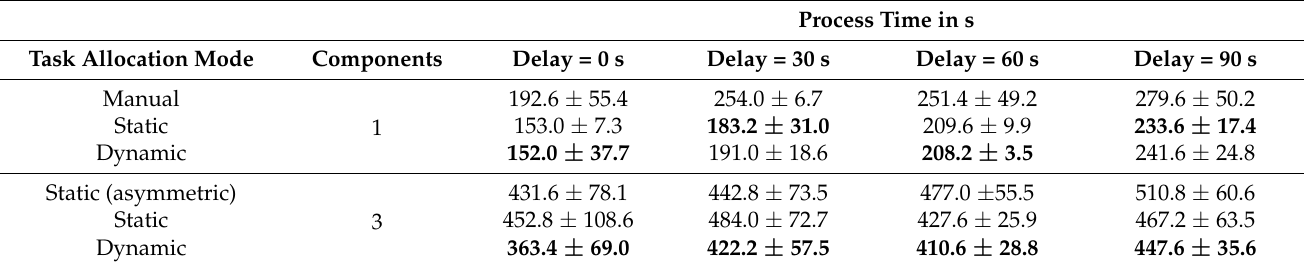
Table 4. Overview of mean process times per task allocation mode and duration of the delay. The task allocation mode with minimum process time is highlighted in bold for each setting.